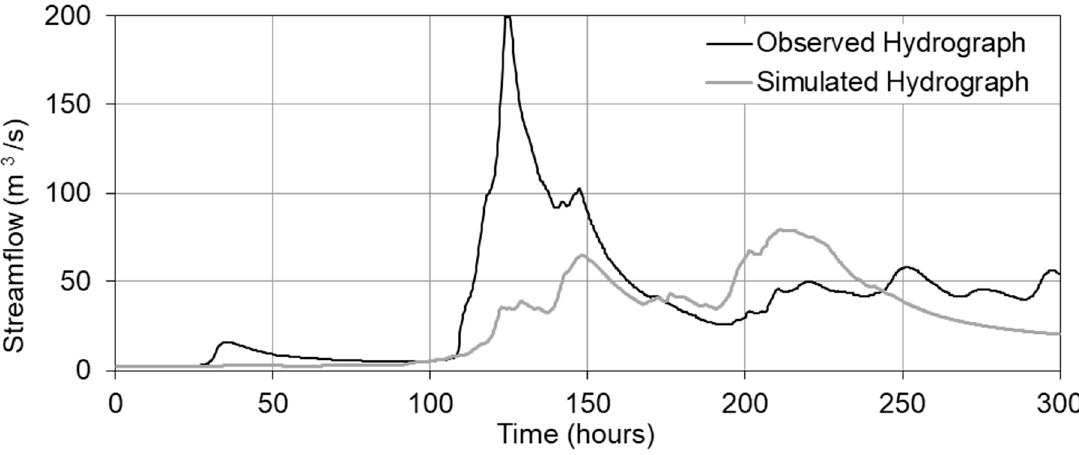
Figure 6. Hydrographs of the January 2009 event of the Esca river in Sigues (A063 stream gauge), actual and simulated, not considering snowmelt.